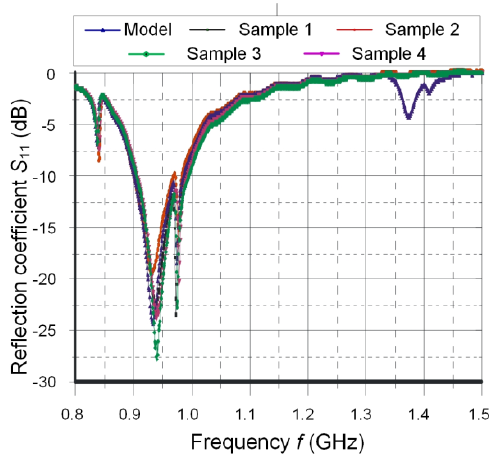
ffi cient S Figure 11. Reflection coefficient S 11 as a function of frequency f for model and test samples. Figure 11. Reflection coe 11 as a function of frequency f for model and test